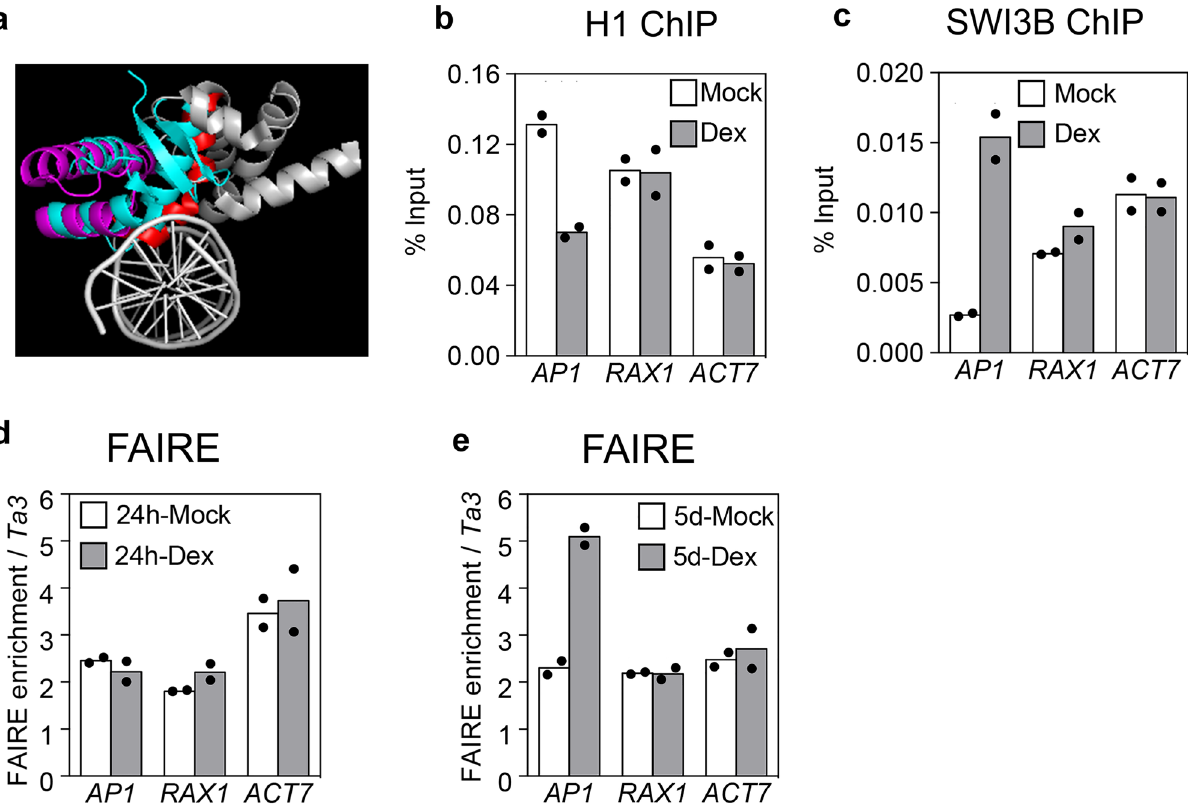
Fig. 6 LFY displaces histone H1 and recruits chromatin remodelers. a Comparison of the structure of linker histone H1 (PDB: 5NL0) and of the LFY DNA binding domain (PDB: 2VY1) bound to DNA. Red: All base contacting residues, including the LFY anchoring helix. Warm pink and red: helix-turn-helix DNA binding domain of LFY. Gray: remainder of the LFY C-terminal domain 54 . Turquoise: H1 linker histone. b Histone H1 ChIP-qPCR at the LFY bound sites of AP1 , RAX1 and ACT7 24 h after dexamethasone (Dex) or control (Mock) treatment. Black dots: means from n = 2 independent biological experiments. c ChIP-qPCR of the SYD and BRM SWI/SNF complex subunit SWI3B at the LFY bound sites of AP1 , RAX1 and ACT7 24 h after dexamethasone (Dex) or control (Mock) treatment. d , e FAIRE qPCR at known DNase hypersensitive sites 73 of the loci indicated 24 h after LFY activation ( d ) or 5-days after LFY activation ( e ) relative to the control (Mock treated plants). Black dots: means from n = 2 independent biological experiments. See also Supplementary Fig. 5.